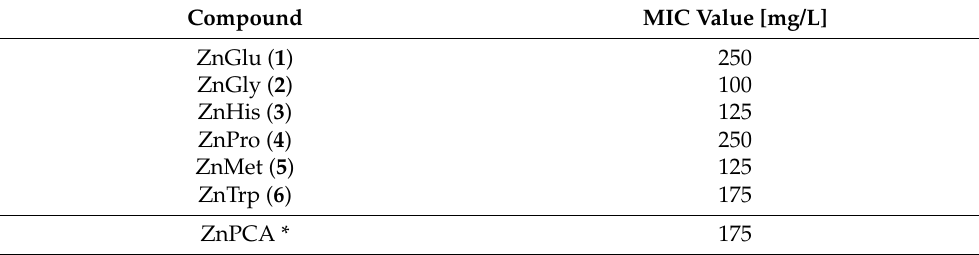
Table 2. Antimicrobial activity against C. acnes of zinc complexes of amino acids ( 1 – 6